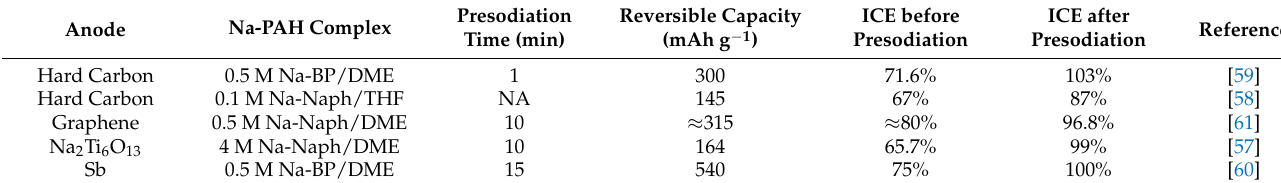
Table 3. Summary of presodiated anode performance adopting various Na-PAH complexes.